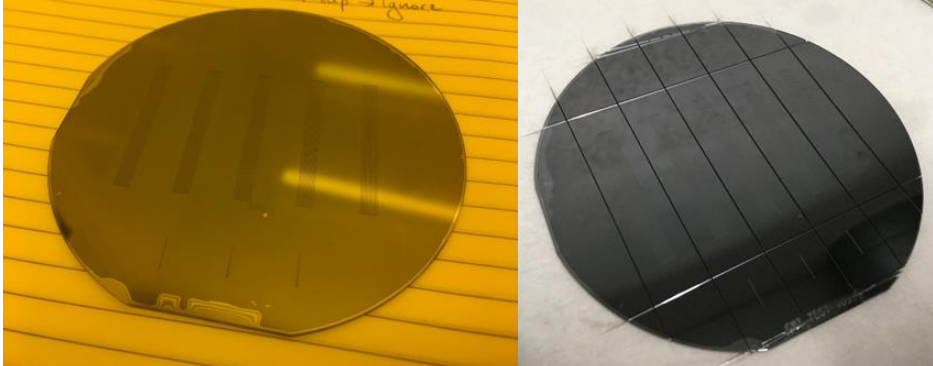
Figure 11. Wafer stack after bonding (left) and dicing (right). Some bonding defects are visible at the wafer edge and one in the inner region, all far from the channels.